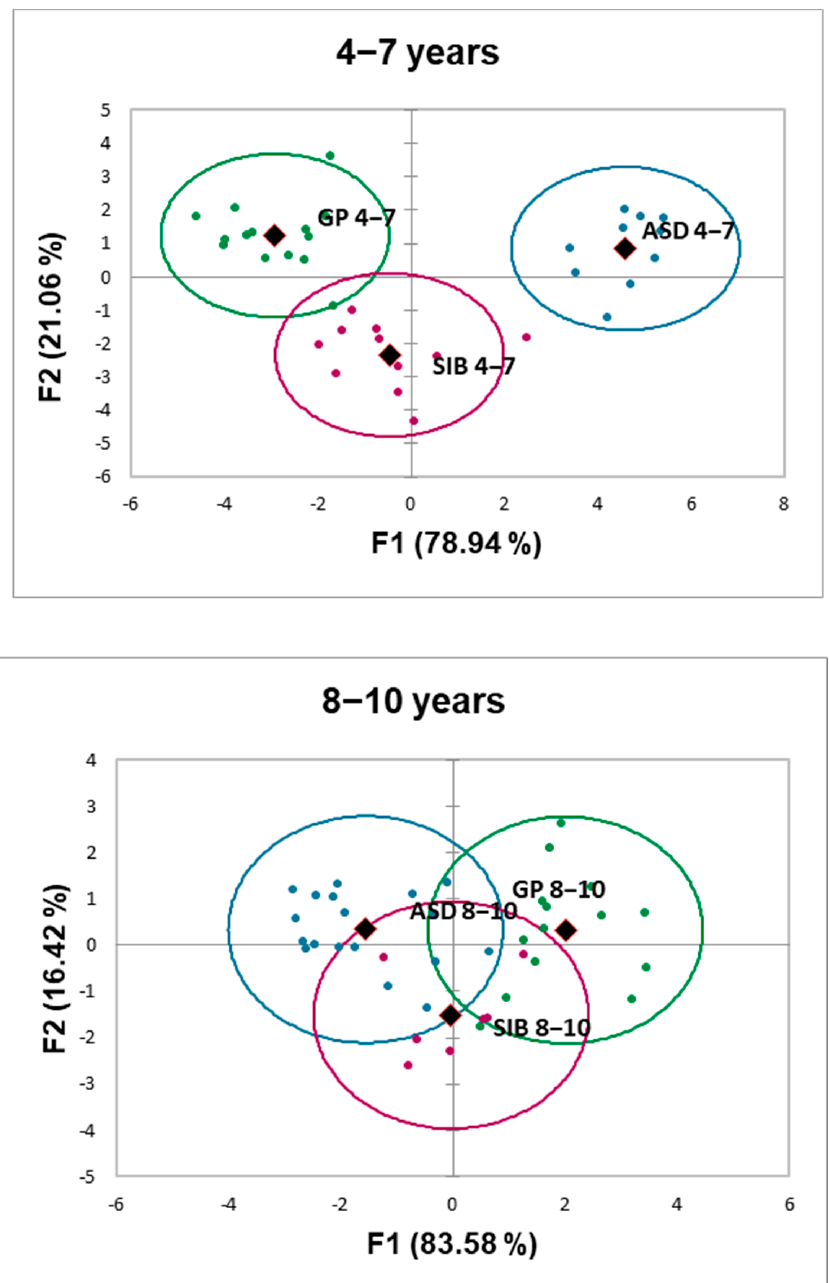
Figure 4. Projection of the metabolic profiles of the three groups of children stratified by age (4–7 years, and 8–10 years) into the plane formed by the two classification functions (F1 and F2) obtained from the linear discriminant analysis based on fecal levels of 19 protein amino acids excluding proline and cysteine and including the non-protein amino acid ornithine. Blue spots represent autistic children: ASD; green spots represent individuals from the general population (GP); purple spots represent the siblings from autistic children (SIB): Oval lines around individual spots are arbitrarily representing groups based on the profile of compounds analyzed. Centroids are indicated with rhomboid shapes. Percentage of variance explained by each of the two functions is indicated within parentheses in each axis.